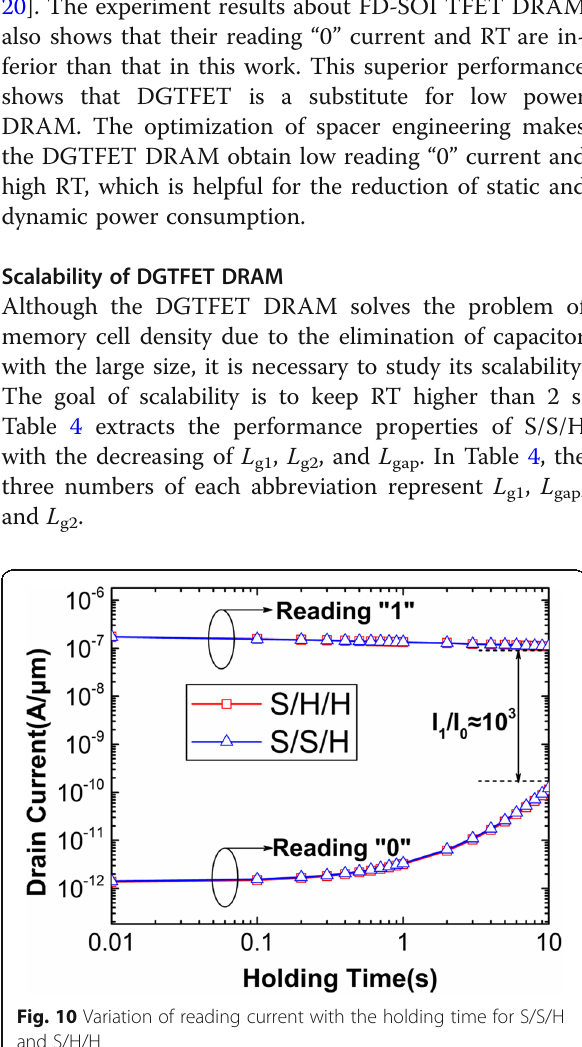
Fig. 10 Variation of reading current with the holding time for S/S/H and S/H/H